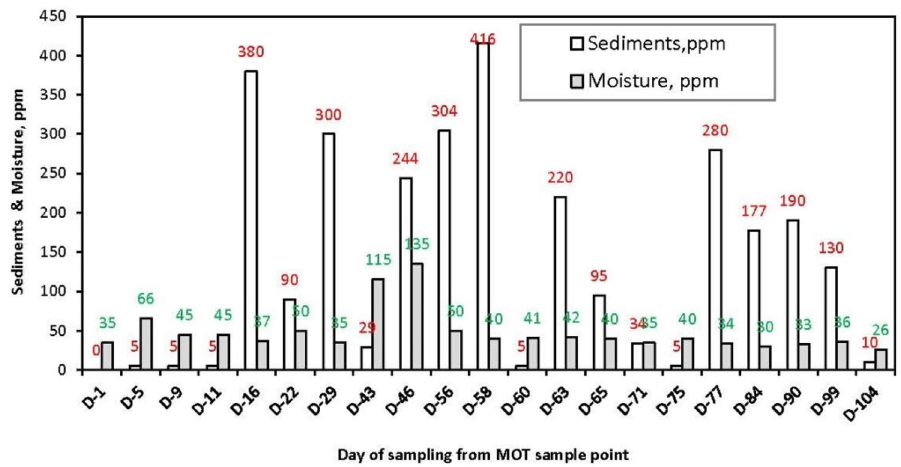
Fig. 5 MOT oil sample analysis for stage-1 and